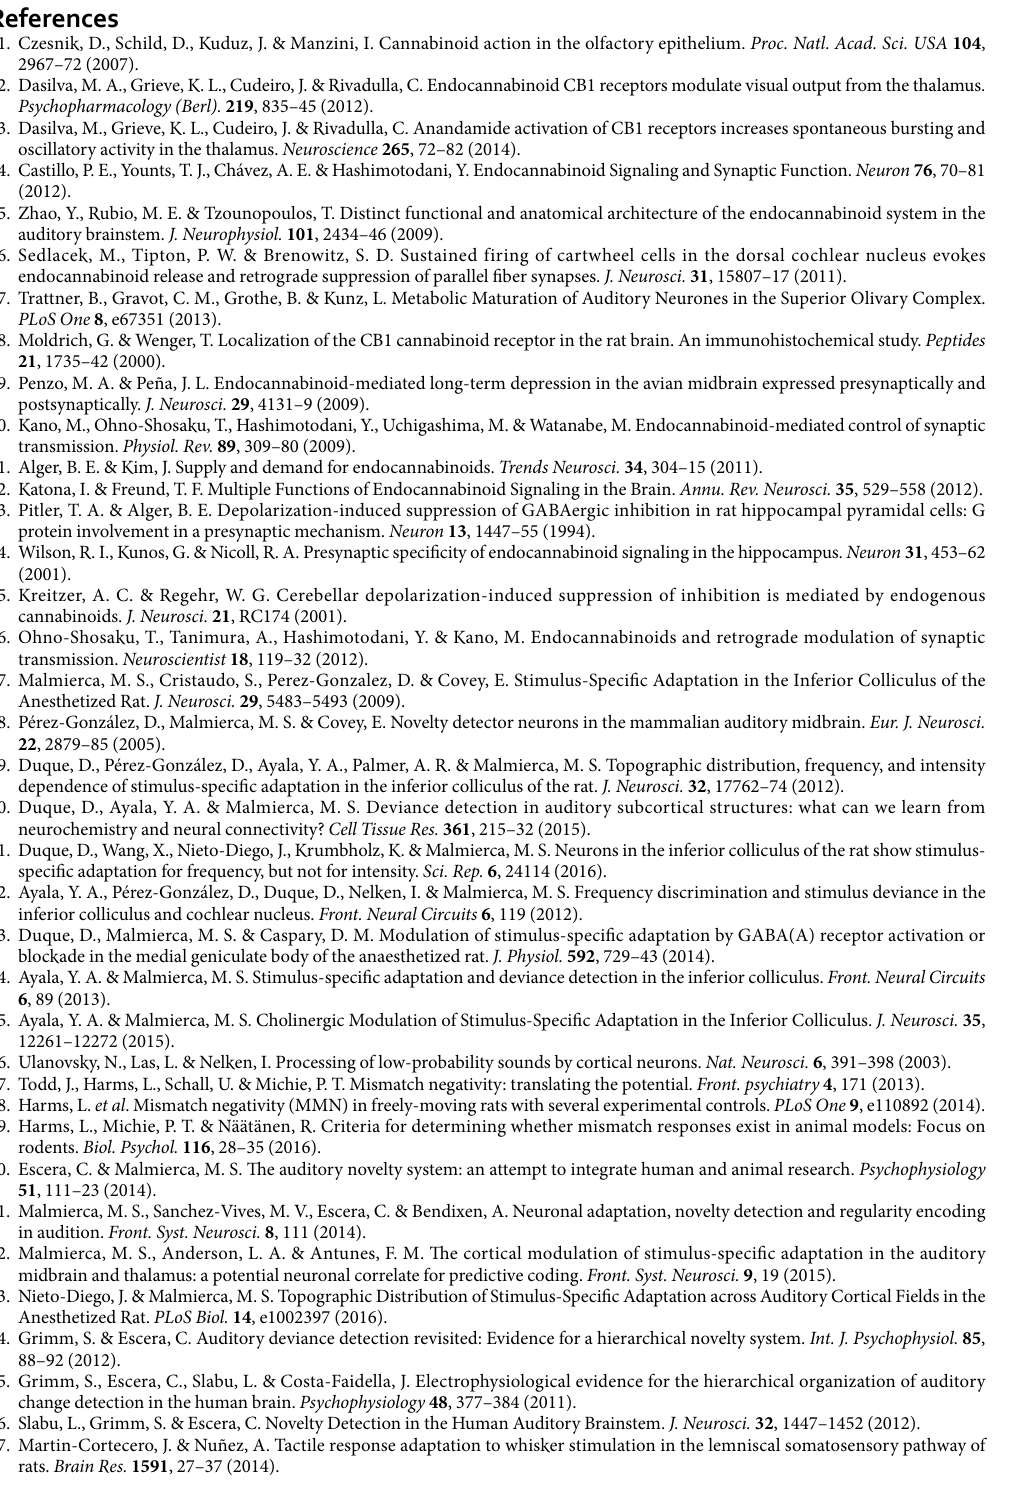
Statistics. Results were analyzed using the Student t-test comparing control condition versus drug application and reported as mean ± SE. When data failed to pass the normality test, a non-parametric Mann-Whitney rank sum test was performed. All analyses were done with Sigma Plot software, except bootstrapping which was done using MATLAB. Data availability